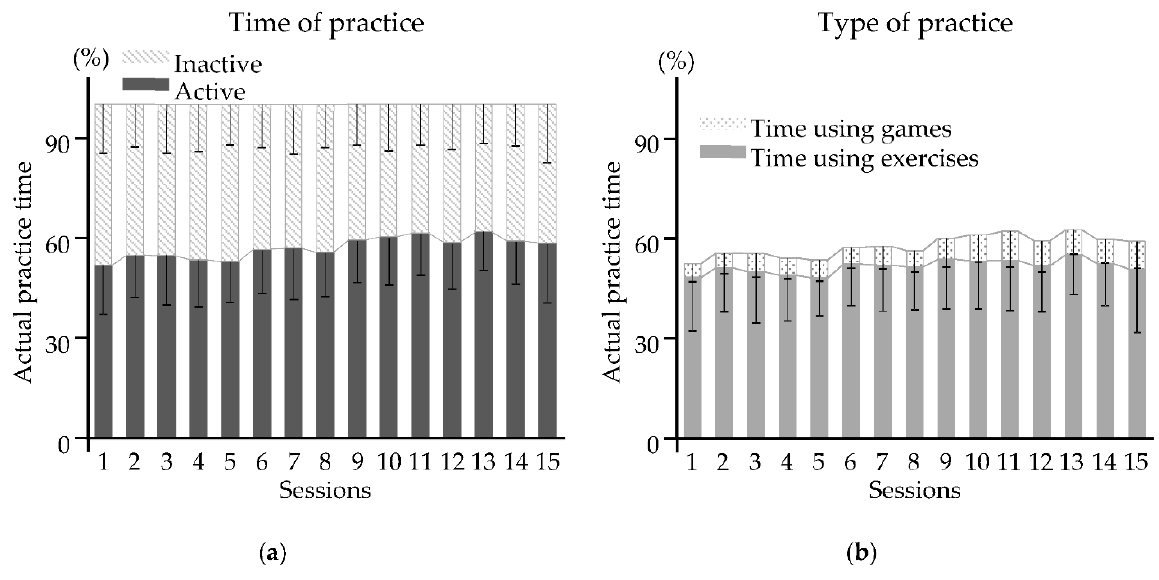
Figure 3. Active and inactive practice time over 15 sessions of RT: ( a ) Time of practice; ( b ) type of practice. Results are expressed as the mean (SD). Practice time (in %) was normalized to a session length of 60 min.